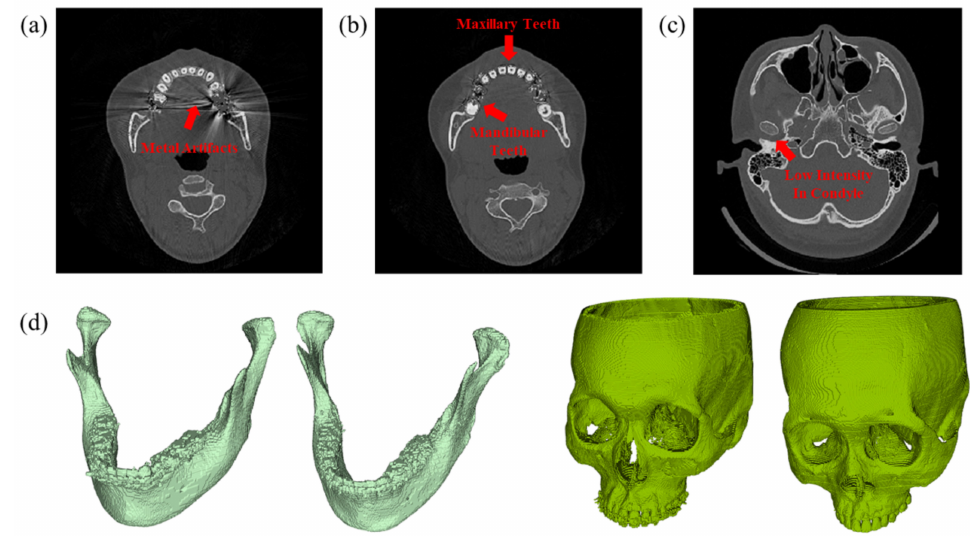
Figure 1. Difficulties in mandible and maxilla segmentation. ( a ) Metal artifacts caused by dental implants ( b ) Difficulty in distinguishing mandibular and maxillary teeth, or mandible and midface ( c ) Low intensity and thin edges in condyle ( d ) Inter-patient anatomical